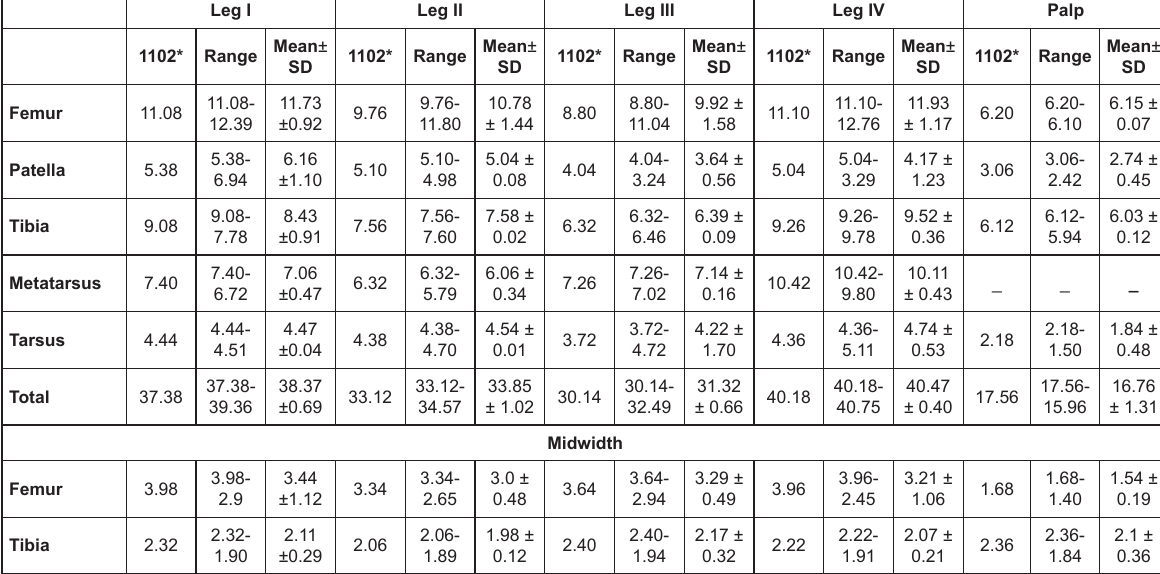
Table 1. Haploclastus validus, measurements of legs and palp of male specimen from Matheran, WILD-10-ARA-1102. Ranges and mean include all male specimens collected from Maharashtra. Leg